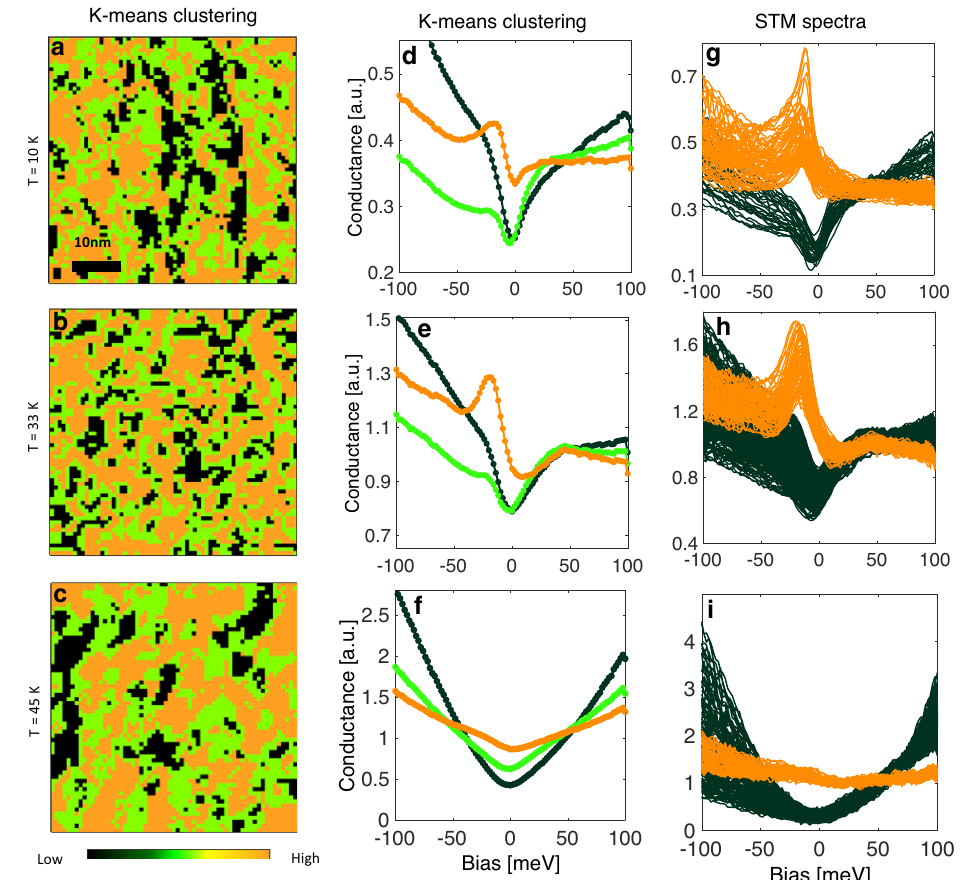
Fig. 3 Machine learning clustering analysis of the spatial inhomogeneity. a – c K -means cluster maps for three temperatures corresponding to the maps shown in Fig. 2a – c. Each map exhibits three main clusters. All images are 40 nm in size. d – f The average of all spectra in each of the clusters from the K -means map. g – i Individual spectra plotted from the orange and black areas of the conductance maps corresponding to the K -means maps. There is a clear difference between the spectra from these different areas at all three